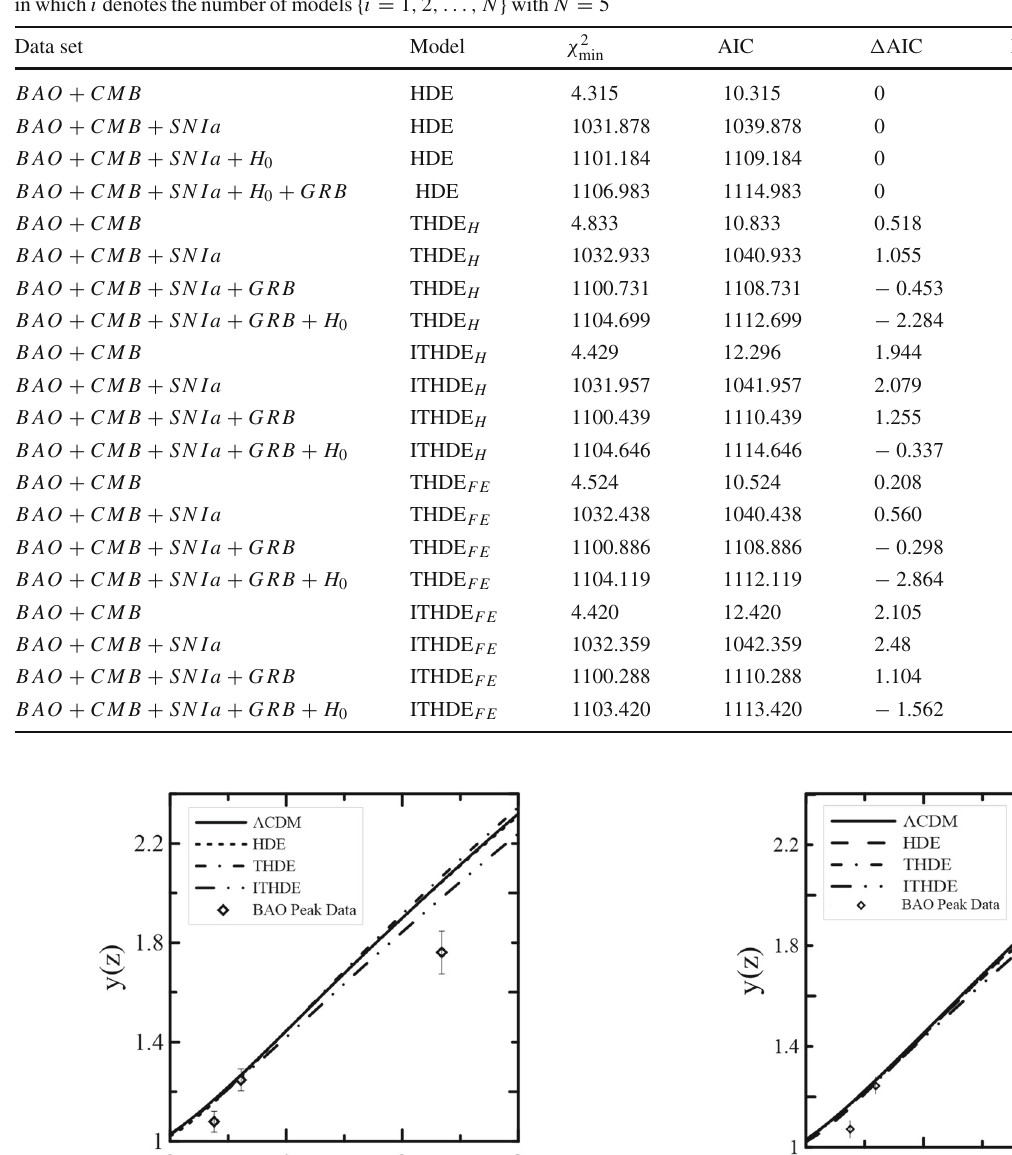
interacting THDE, N = 4 for non-interacting THDE and N = 4 for the HDE models. Here we have 1169 data points. The H and FE index stand for the Hubble horizon and the future event horizon respectively